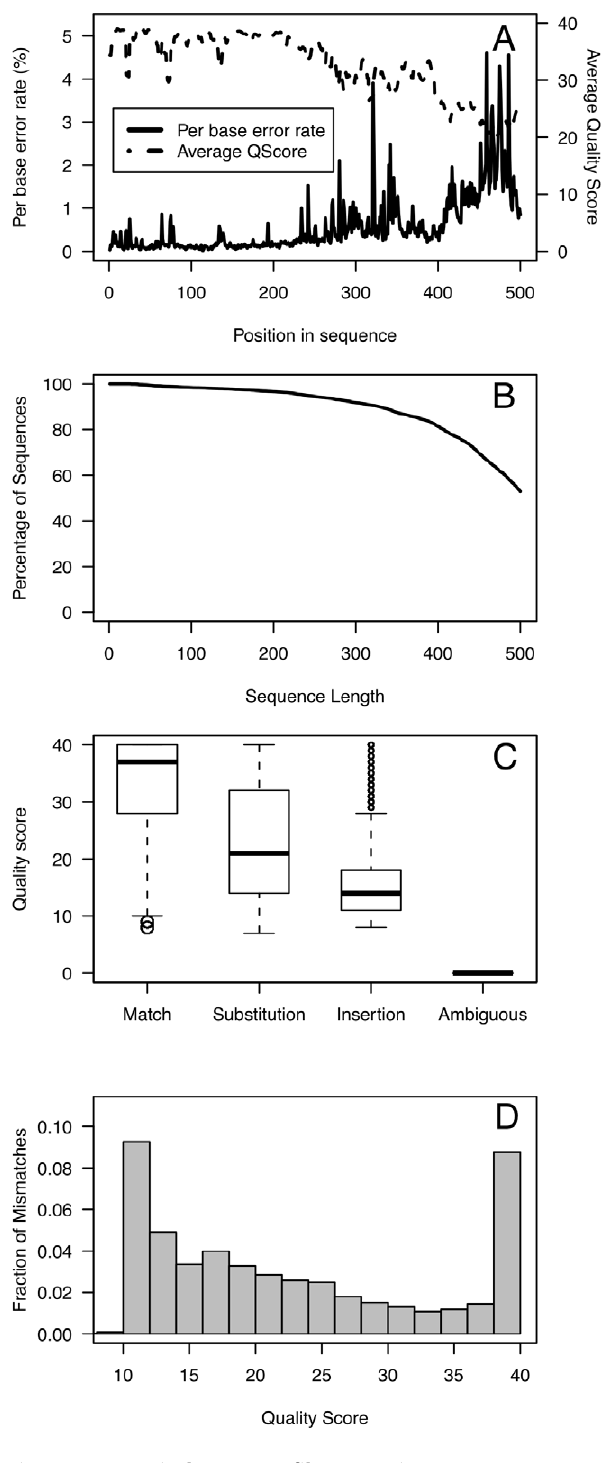
Figure 2. A typical error profile (accession SRX020131, V35, replicate 1) generated by sequencing the mock community without any sequence curation measures. doi:10.1371/journal.pone.0027310.g002 average error rate of 0.0034 (sd= 0.0006; Fig. 1, ‘‘Translated flows’’). After processing these flowgrams through shhh.flows the error rate dropped to 0.0016 (sd =0.0006; Fig. 1, ‘‘shhh.flows’’). Based on our observation that sequence quality dropped after